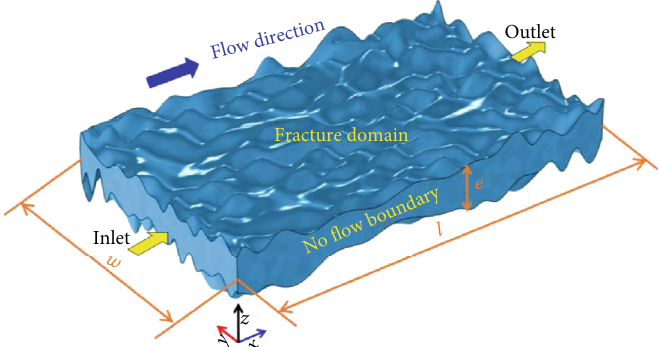
Figure 7: Geometry and boundary conditions for numerical